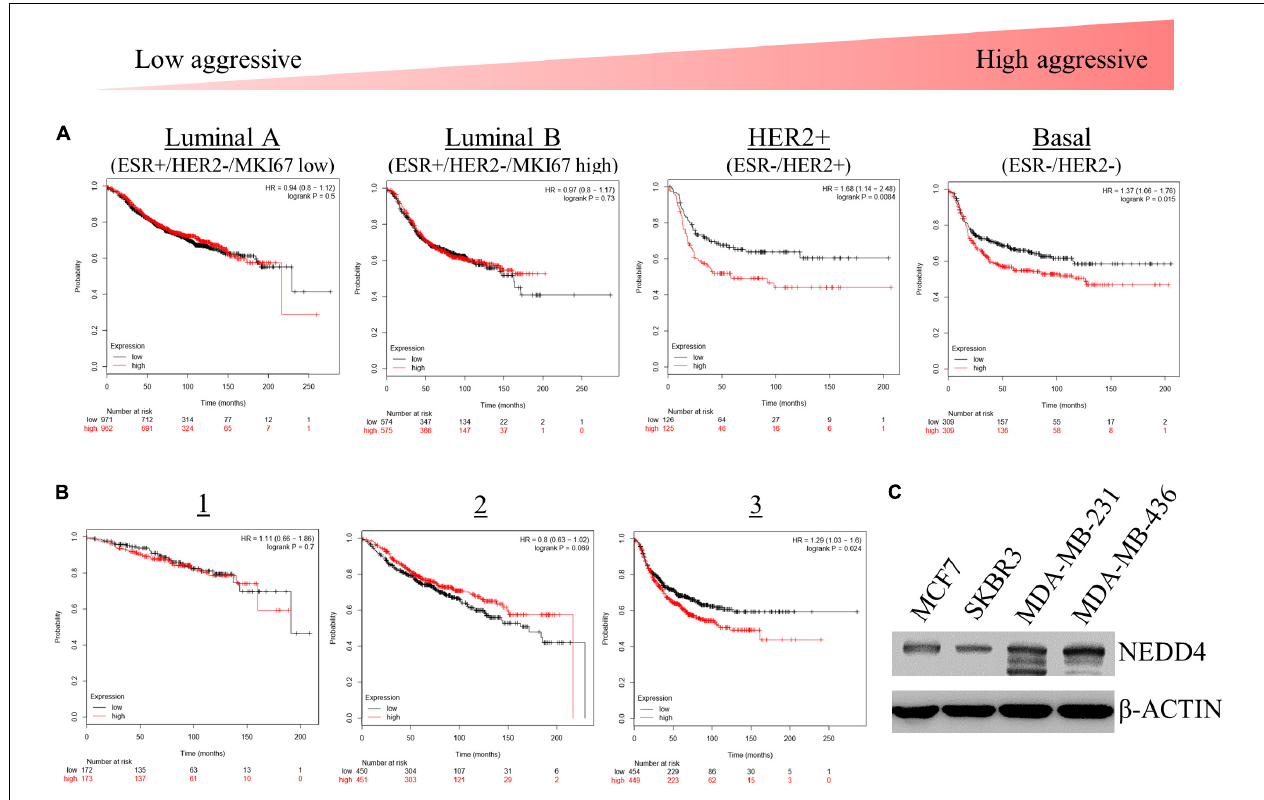
FIGURE 1 | The expression level of NEDD4 is negatively correlated with the survival rate in aggressive breast cancer patients. (A,B) The Kaplan–Meier survival curve showing the correlation between the level of NEDD4 expression and the aggressiveness and stage in breast cancer patients. (C) The expression of NEDD4 was confirmed in human breast cancer cell lines by western blot with an anti-NEDD4 antibody. β -actin was used as a loading